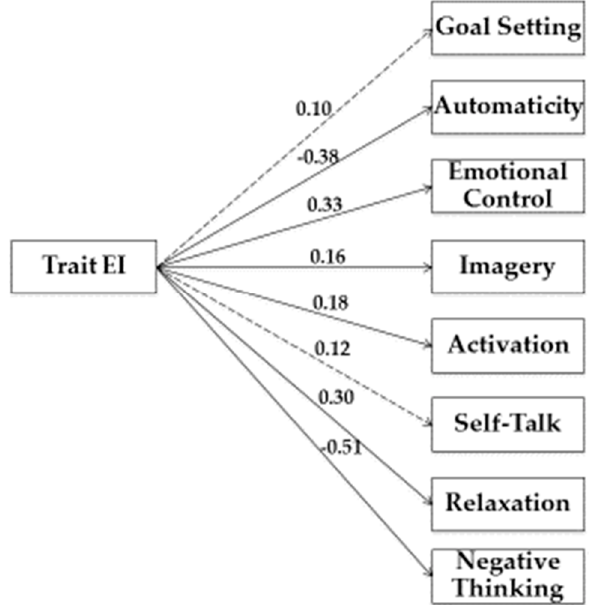
Figure 2. Structural model of associations between Trait EI, Need Fulfiment, and competition strategies. Note: Coefficients shown are standardized path coefficients. Dotted lines represent non-significant relations.